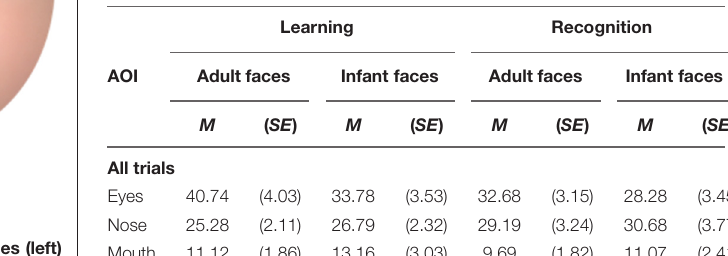
FIGURE 2 | Example of areas of interest (AOI) plots for adult faces (left) and infant faces (right).